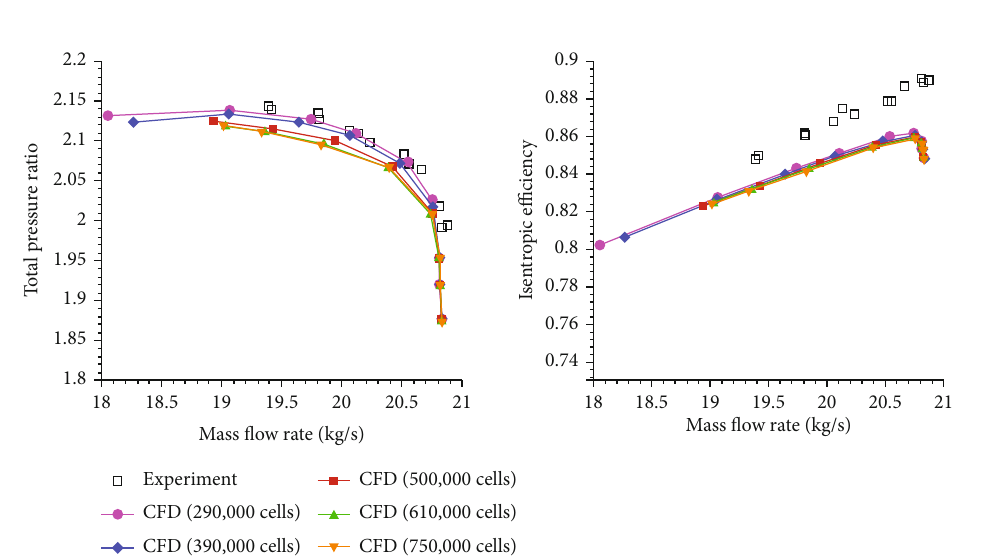
Figure 3: Outline of 2D pro fi le parameterization.